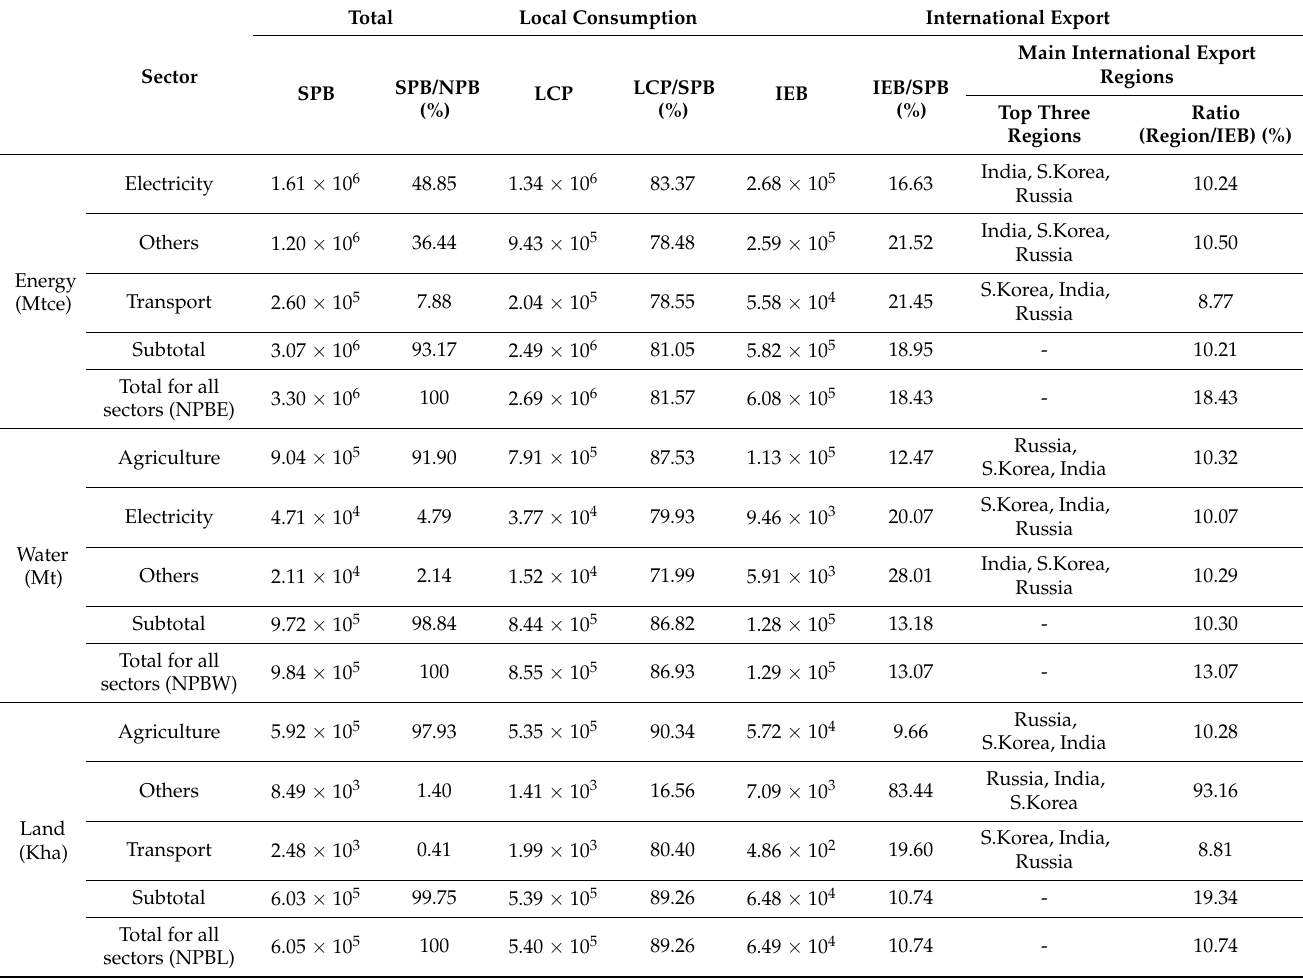
Table A2. Industrial structure of production-based energy–water–land use flow of China in